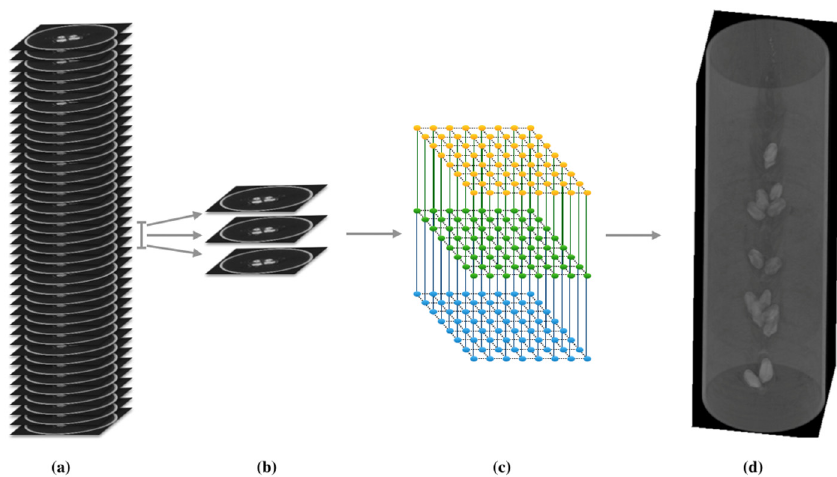
Figure 5. Stack 2D image sequence into 3D image. ( a ) The original group of 2D images; ( b ) Three example images; ( c ) The 2D matrices of each image are stacked along the vertical direction. Their horizontal coordinates remain unchanged. The coordinate values in the vertical direction are their numbers in the image group; ( d ) The result of stacked 3D images.